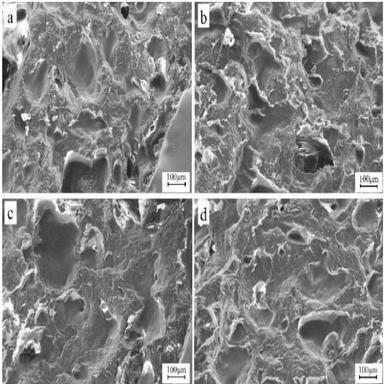
SEM images of (a) C500, (b) C700, (c) C900, (d) C1100 after thermal cycling.